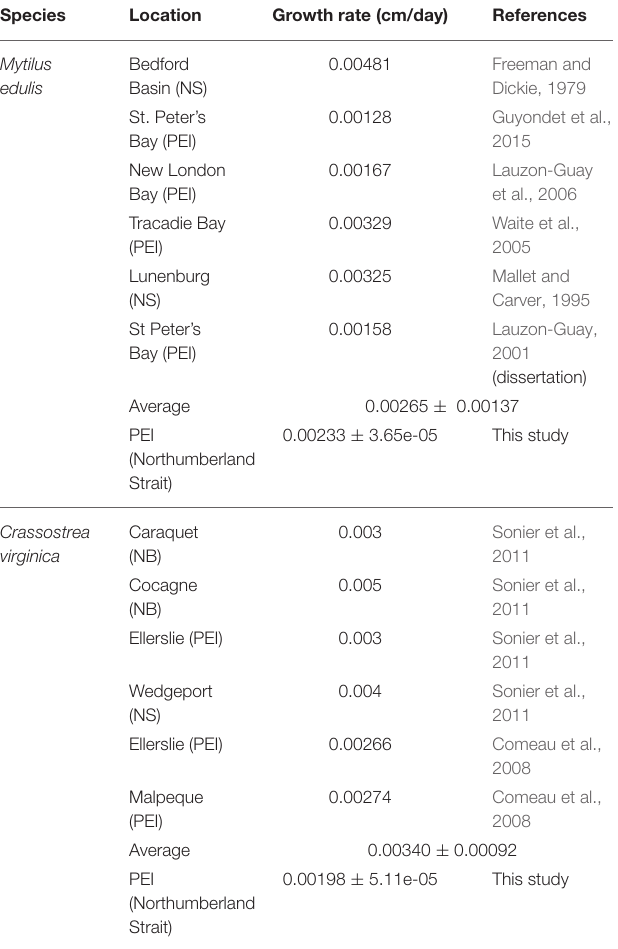
TABLE 3 | Review of observed growth rates of Mytilus edulis and Crassostrea virginica used to validate the DEB model output.